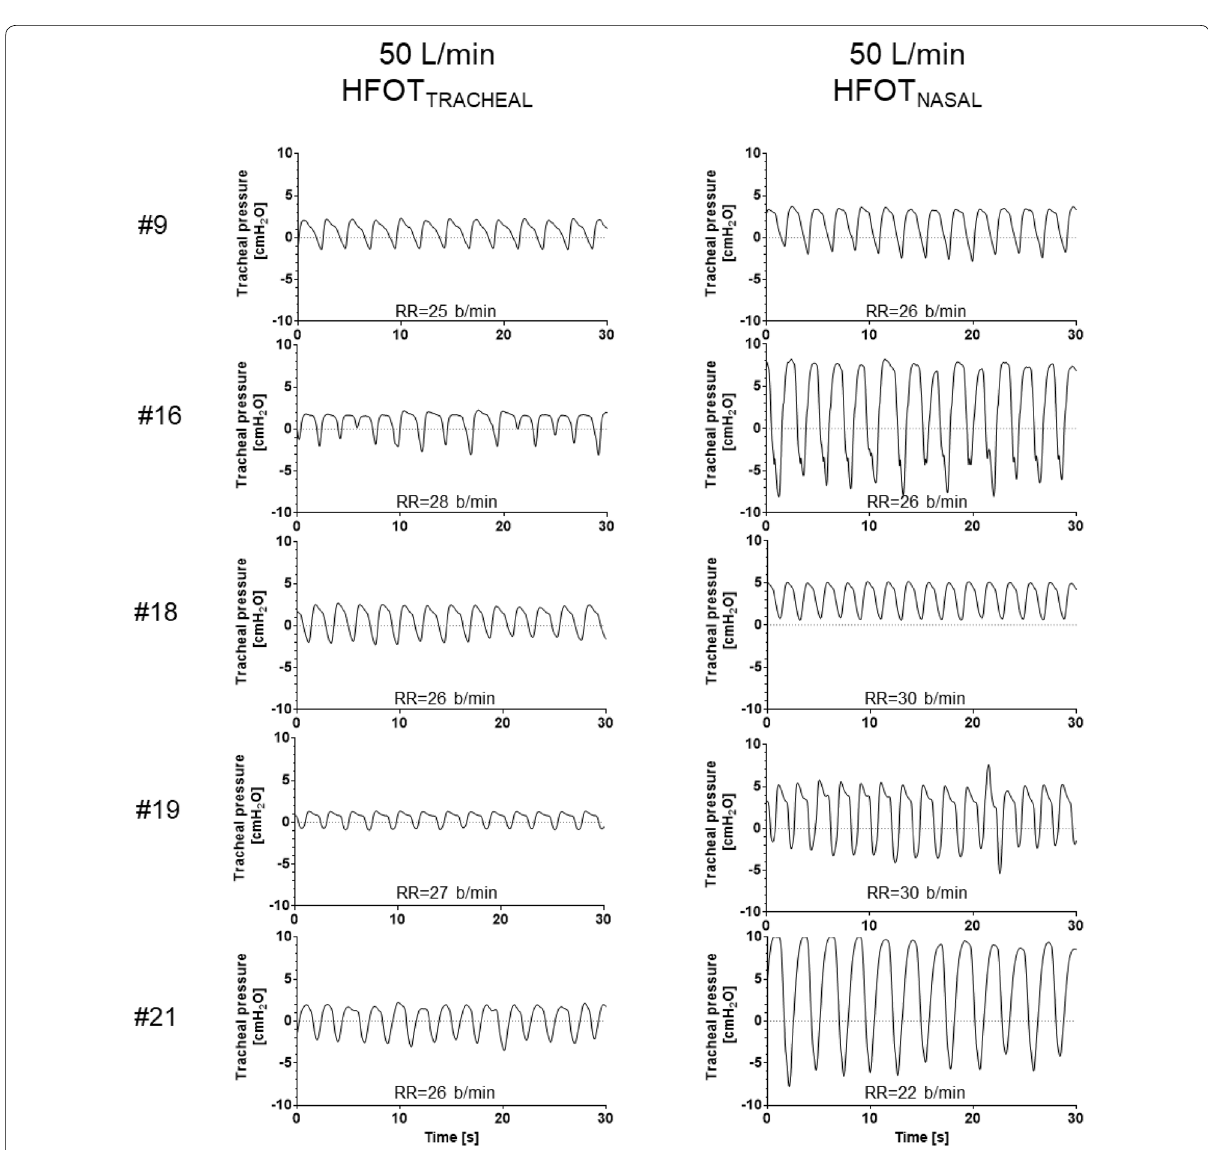
Fig. 3 Thirty-second recordings of tracheal pressure tracings during HFOT TRACHEAL and HFOT NASAL in 5 patients who underwent tracheostomy decannulation over the course of ICU stay. In both conditions gas flow was set at 50 L/min. Average respiratory rate for the 30-s recording is reported for all conditions. During HFOT NASAL lower airway pressure during expiration is higher and more inter-individually variable than HFOT TRACHEAL , despite a non-dissimilar respiratory rate, which was calculated on the same 30-s recording. This suggests that the HFOT NASAL -induced increase in expiratory pressure depends not only on gas flow, but also on patient’s expiratory pattern and, likely, on individual respiratory system mechanical properties. Please note that, under this condition, tracheal pressure was not constant over the course of the respiratory cycle and became negative during inspiration in 4 patients, which is different from what previously reported for pharyngeal pressure